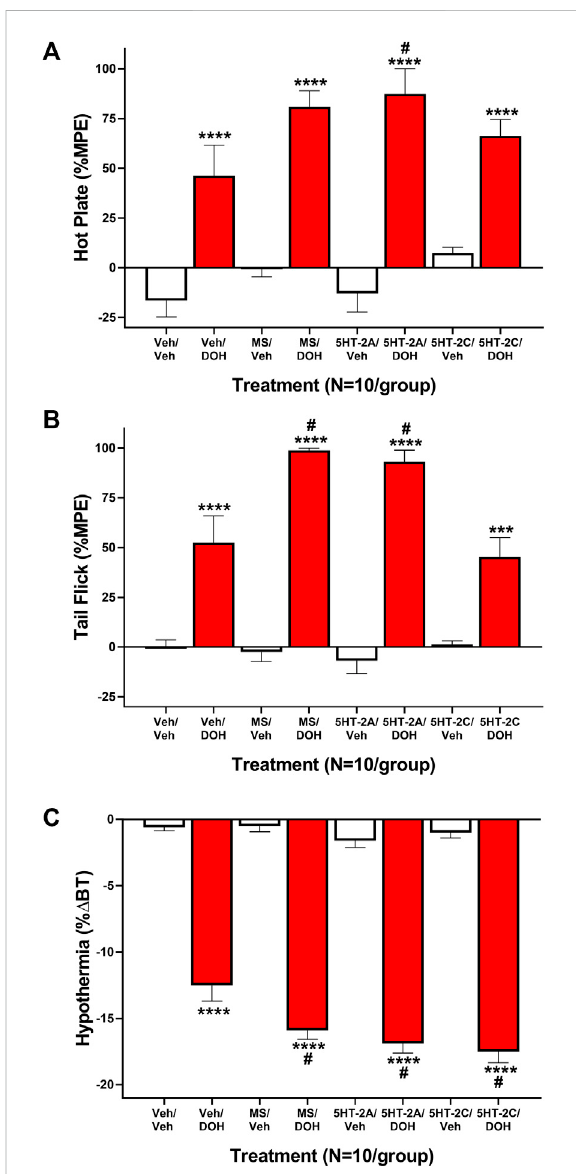
FIGURE 4 Serotonin Receptor 2 (5-HT 2 ) signaling does not attenuate decursinol-inducedantinociceptionorhypothermia.Mediationofthe acute antinociceptive (A/B) and hypothermic (C) effects of 50 mg/kg decursinol by 5-HT 2 antagonists in male mice. Mice (N = 10) were assessed for hot plate (A) and tail- fl ick (B) antinociception (% MPE)andhypothermia(C;% Δ BT)30 minfollowing pretreatmentwith either vehicle (VEH), 4 mg/kg of the non-selective 5-HT 2 antagonist Methysergide (MS), 4 mg/kg of the selective 5-HT 2A antagonist Volinanserin (5-HT 2A ), or 4 mg/kg of the selective 5-HT 2C receptor antagonistSB-242084(5-HT 2C )andagain30 minfollowingtreatment with either vehicle (VEH; un fi lled bars) or 50 mg/kg of decursinol (DOH; fi lled bars). Error bars represents the mean ± SEM. Data were analyzedusingarepeatedmeasuresone-wayANOVAwithBonferroni post-hoc tests (*** p < 0.001; **** p < 0.0001 compared to VEH/VEH; # p < 0.05 compared to VEH/DOH).